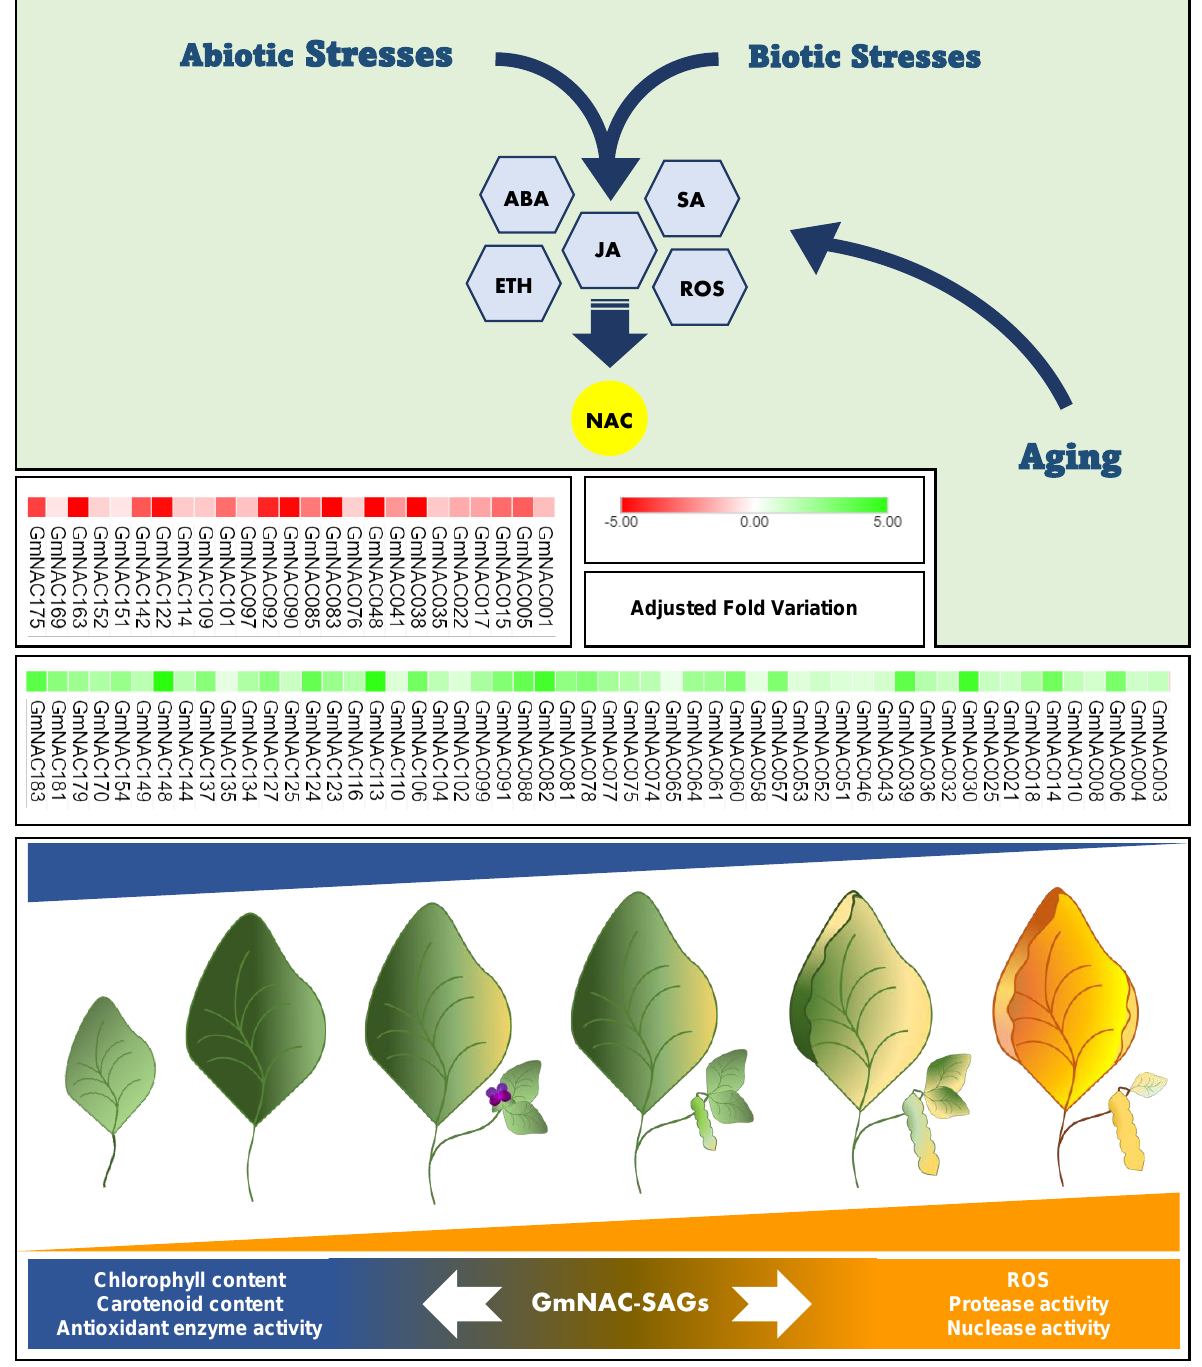
Figure 1. Integrated environmental and developmental senescence mechanisms in soybean and GmNAC-SAGs involved in this process. Senescence is a naturally controlled program that culminates in nutrient recycling before plant reproduction. The biological event is complex and finely regulated by several gene networks integrating different TF families, including NAC-TFs. During ongoing senescence, plant metabolism undergoes drastic changes imposed by the extensive gene expression reprogramming coordinated by phytohormones, especially ABA, ETH, JA, and SA. However, these hormones also serve as stress signalers in plants subjected to multiple stresses, overlapping the developmental and stress-responsive mechanisms that converge to programmed cell death (PCD). Conceptually, PCD is classified as developmental PCD (dPCD) and environmental PCD (ePCD), according to the signal’s